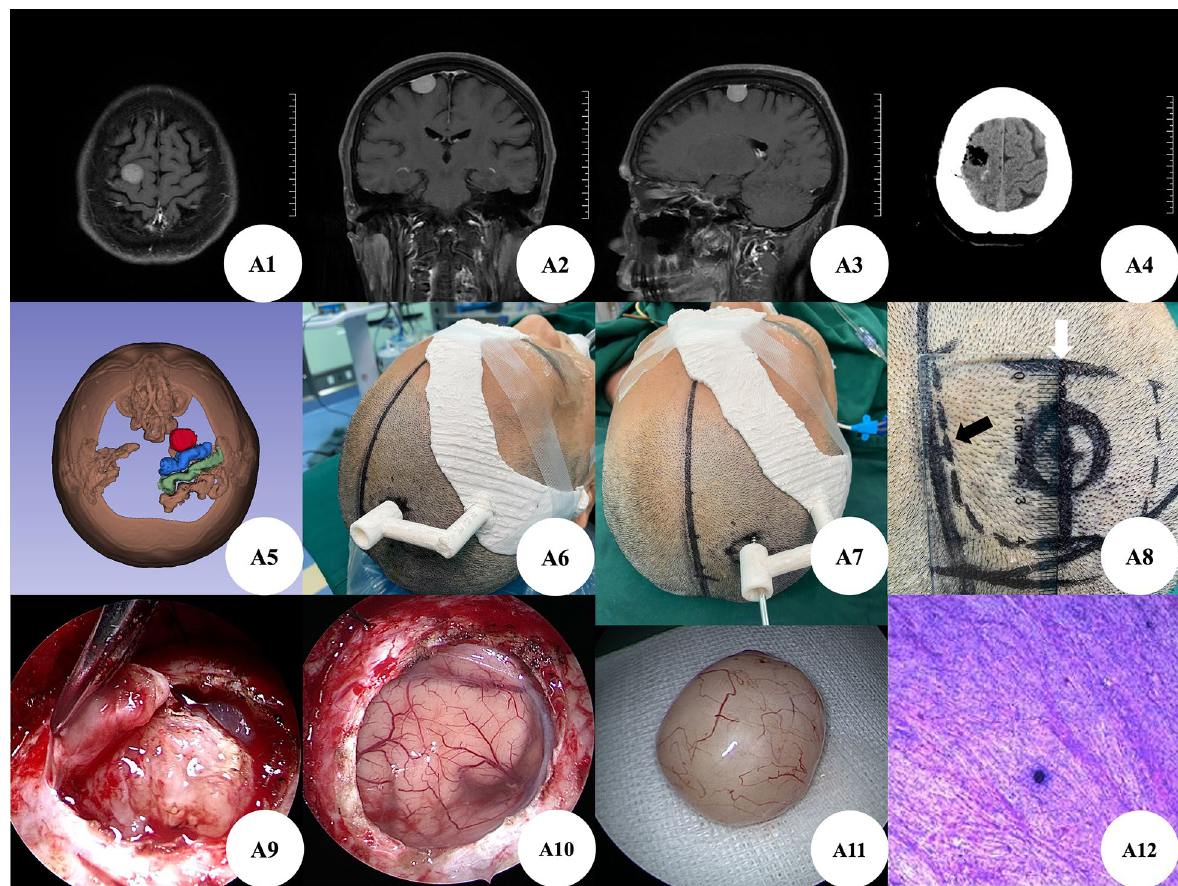
Figure 2. ( A1 – A3 ): Brain MRI enhancement showed right frontal lobe space occupying lesions with uniform enhancement and clear boundary; ( A4 ): Postoperative brain CT showed that the intracranial lesions were removed completely; ( A5 ): Relationship between intracranial lesions and brain tissue of anterior central gyrus and posterior central gyrus reconstructed by 3D-Slicer; ( A6 – A7 ): 3D printing positioning guide; ( A8 ): According to the surgical incision design after 3D positioning guide plate positioning, the circle is the body surface projection of intracranial lesions, the solid line straight incision is the improved small incision, the ruler shows that the surgical incision is about 4 cm, and the dotted line “U” incision is the conventional surgical incision; ( A9 ): The lesion can be seen by cutting the dura mater under transcranial neuroendoscopic; ( A10 ): The lesion was removed cleanly without obvious side injury to the surrounding tissue under transcranial neuroendoscopic; ( A11 ): Completely resected lesions; ( A12 ): The postoperative pathological